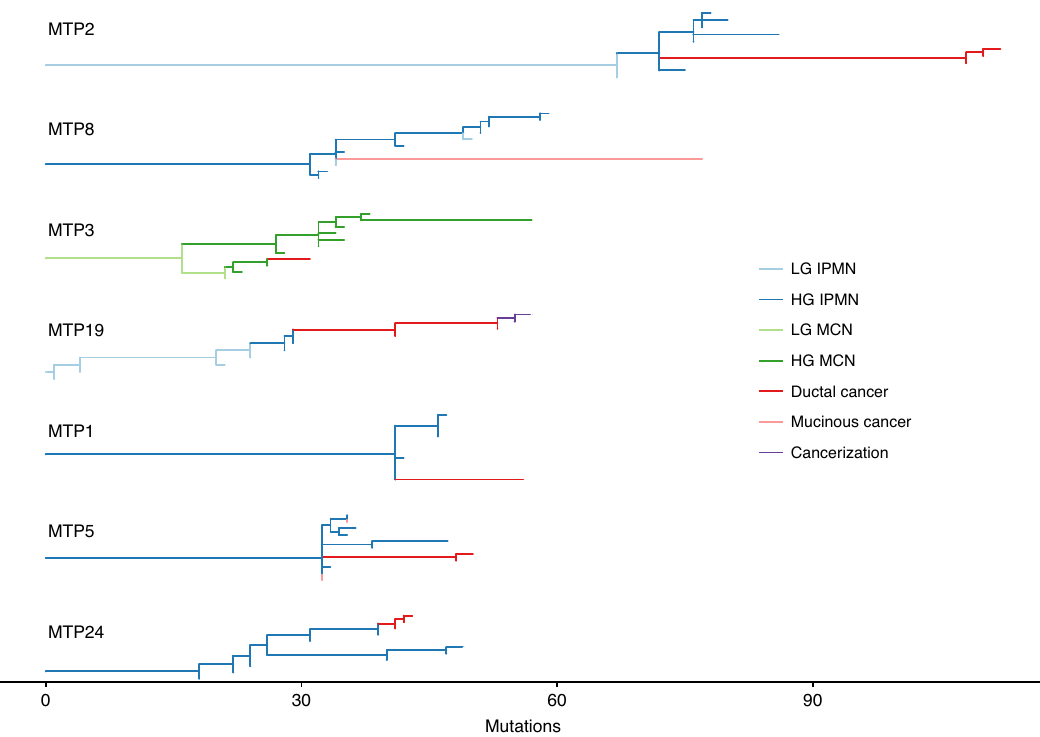
Fig. 4 Evolutionary reconstruction of samples analyzed by whole exome and targeted sequencing. In all cases, noninvasive samples (blue/green) precede invasive samples (red/pink) in the evolutionary history. In MTP5, different invasive cancer samples are placed in different regions of the phylogeny, highlighting multiple independent invasion events in this lesion. In MTP19, a sample of cancerization (purple) has descended from invasive cancer